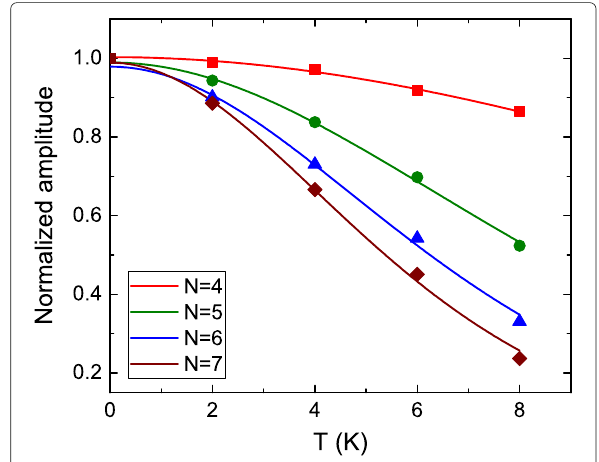
Fig. 4 The extracted normalized SdH oscillation amplitude as a function of temperature at different Landau levels. It agrees well with the LK theory and reveals different tendency at different Landau